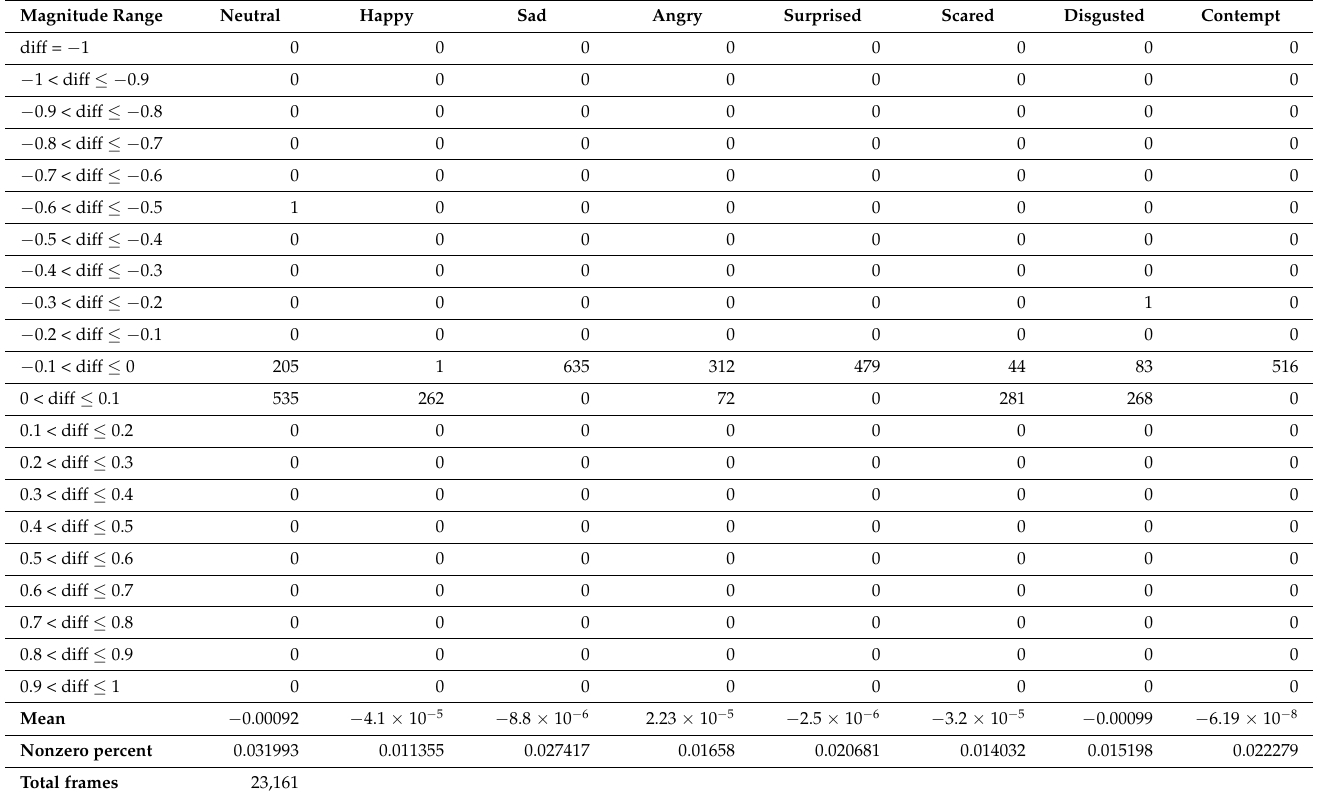
Table A4. Example distributions of test 1 –test 2 differences, with corresponding means, separately for the 8 emotions: subject #65 (ASD). Frequency distributions include only data points with intensity values assigned in both test 1 and test 2 (therefore numerical difference could be calculated); however, matching data points with zero difference were omitted. Nonzero percent row shows the relative frequencies of mismatching data points for each emotion. As emotion intensities are scaled from 0 to 1 by FR8, the difference between two corresponding data points ranges between − 1 and 1; in absolute value between 0 and